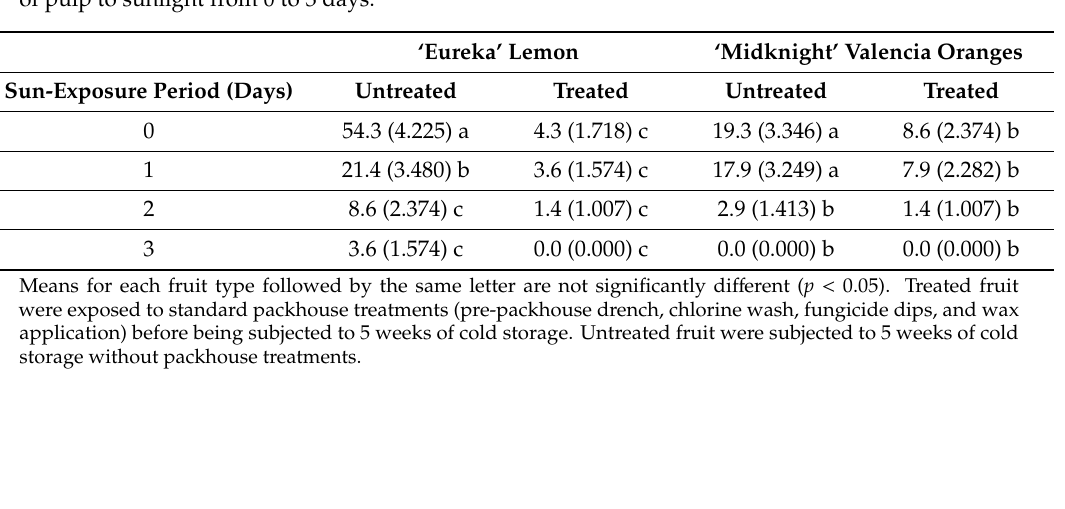
Table 3. Mean percentage (standard error) of CBS lesions which released pycnidiospores on untreated ‘Eureka’ lemon and ‘Midknight’ Valencia orange peel pieces in pulp from processed fruit after exposure of pulp to sunlight from 0 to 3